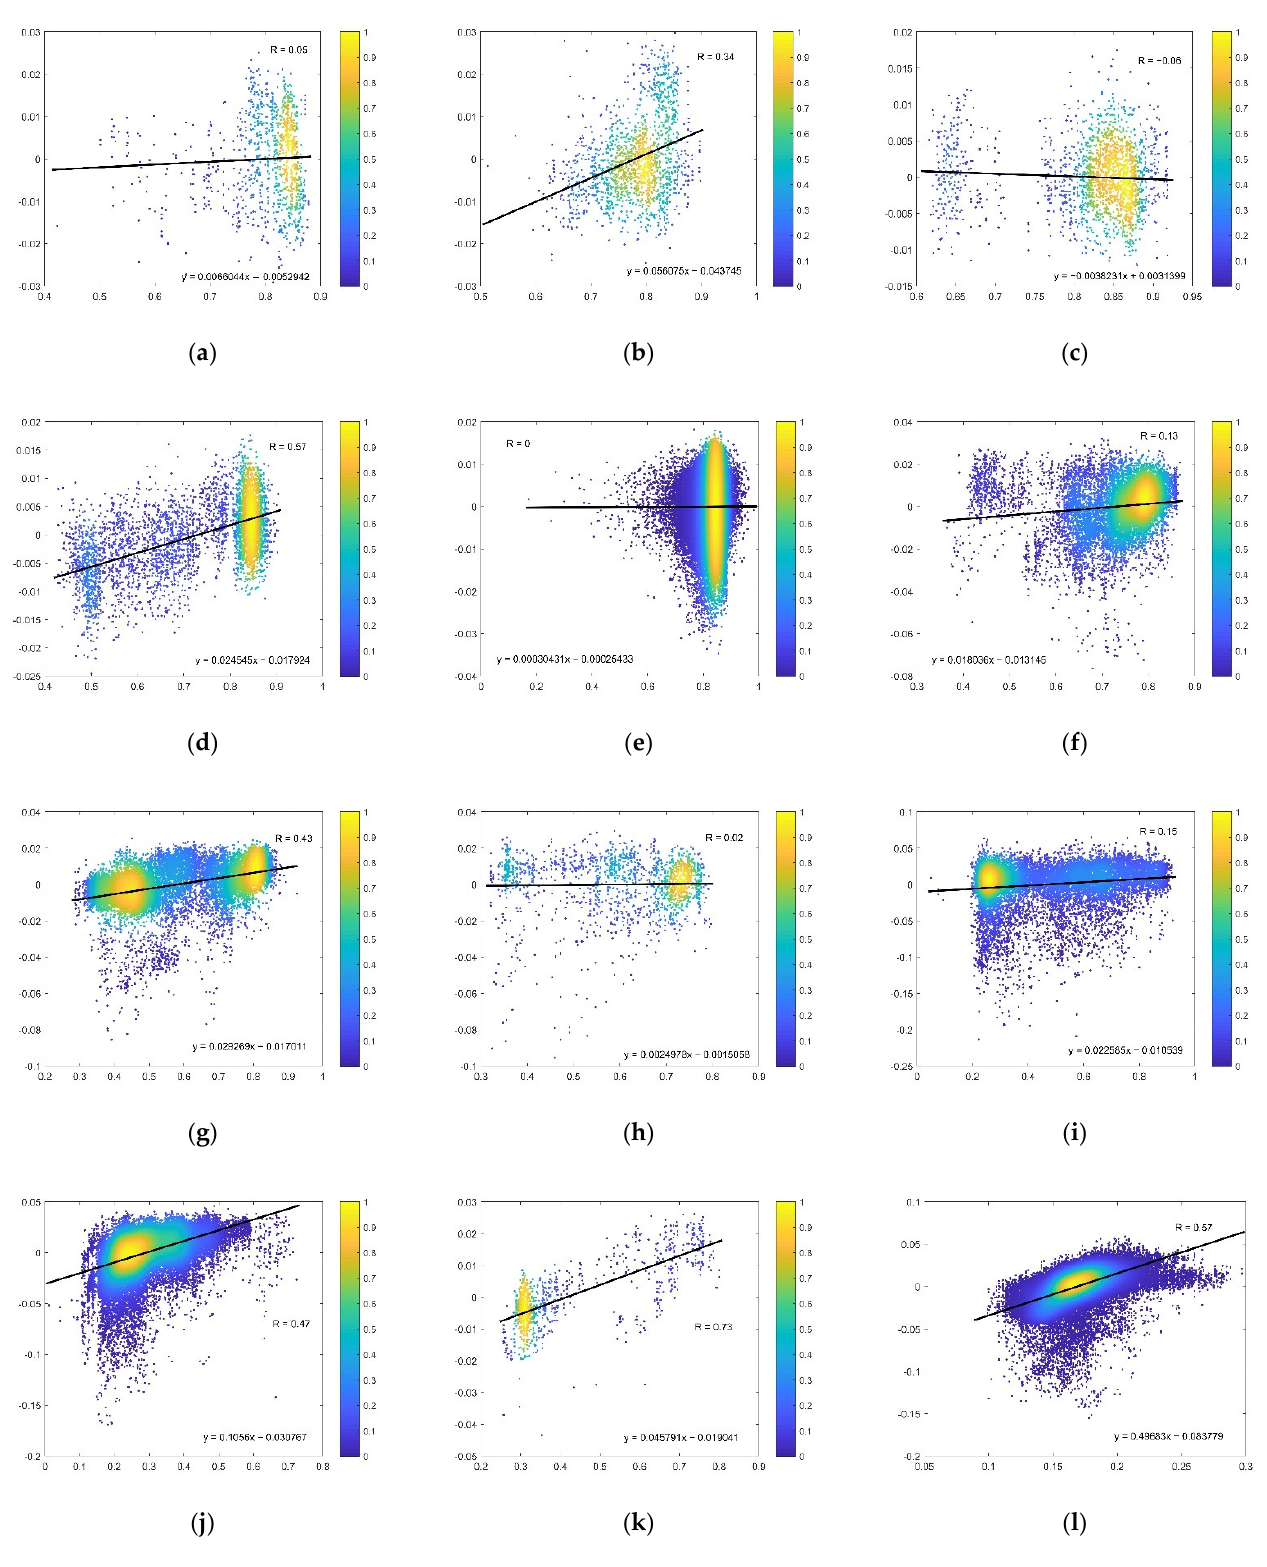
Figure 6. The density scatter diagrams between Delta1 (vertical axis) and NDVI (horizontal axis) for the 12 vegetation types. ( a ) deciduous needleleaf forests; ( b ) evergreen needleleaf forests; ( c ) mixed forests; ( d ) deciduous broadleaf forests; ( e ) evergreen broadleaf forests; ( f ) woody savannas; ( g ) savannas; ( h ) cropland/natural vegetation mosaics; ( i ) croplands; ( j ) grasslands; ( k ) closed shrublands; ( l ) open shrublands.